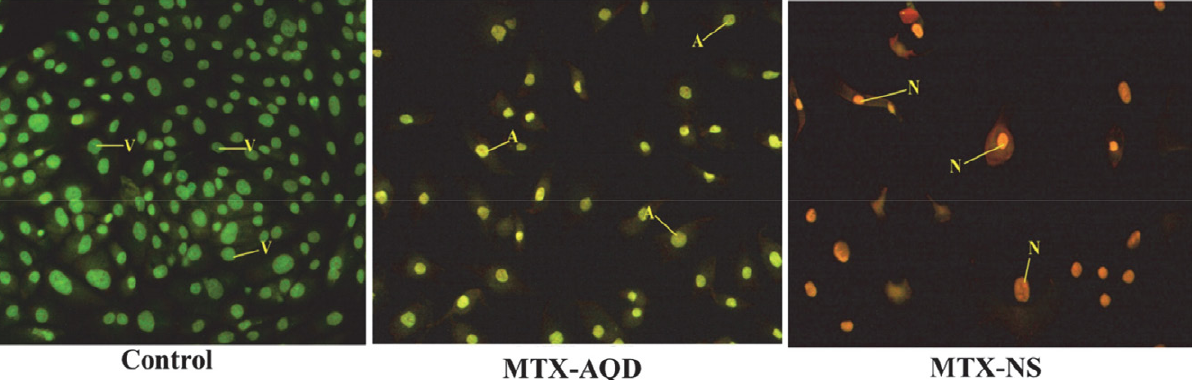
Figure 11. Apoptosis study of MST-NS on MCF-& cells. A) Untreated cell lines that are intact and with green nucleus B) Cells treated with 25 μg/ml of AQD C) Cells treated with 25 μg/ml of NS; N-necrotic Cells, A- Apoptic cells, and V- Viable